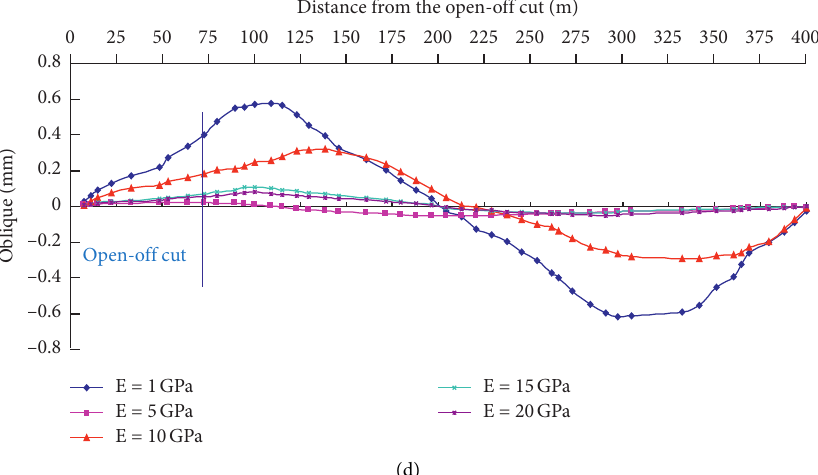
Figure 18: Surface deformation laws under different elastic moduli of backfilled gangue. (a) Surface subsidence. (b) Horizontal deformation. (c) Curvature deformation. (d) Inclination